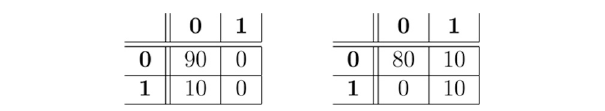
FIGURE 1 | Two examples of confusion matrices with true class labels on the rows and predicted class labels on the columns. Both confusion matrices have the same estimated prediction accuracy, i.e., ˆ PA = 90 + 0 = 80 + 10 = 0 . 1. Nevertheless in the first case there is no 100 100 evidence that the classifier is able to discriminate 0 from 1 , while in the second one there